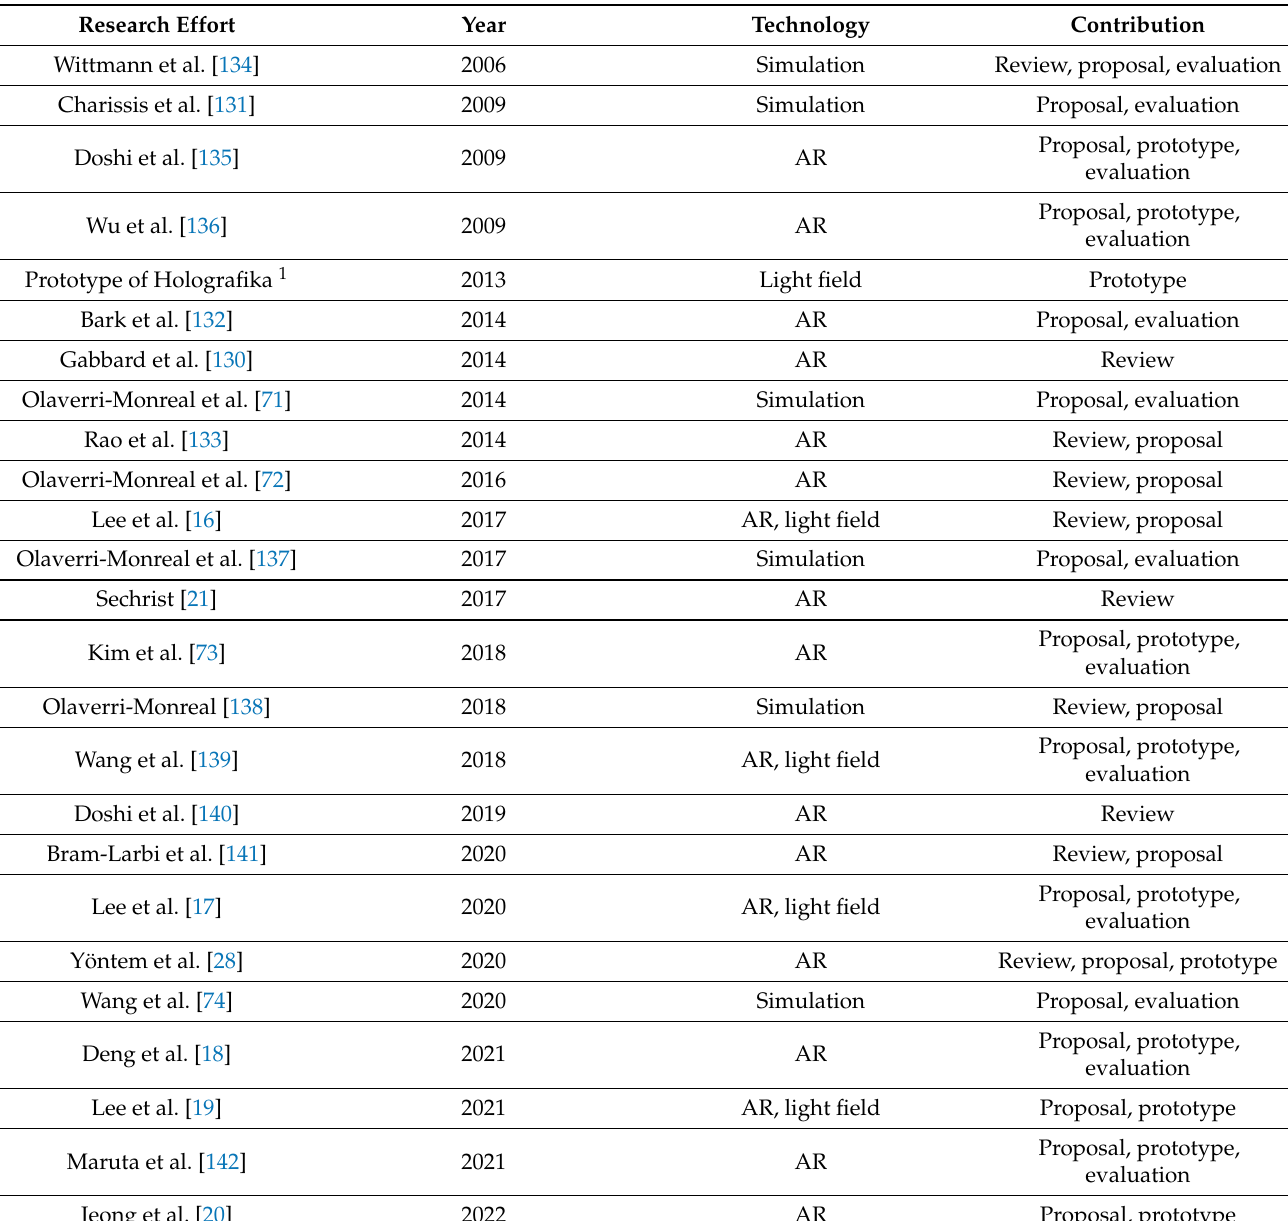
Table 3. Summary and comparison of the scientific literature on immersive windshield interface